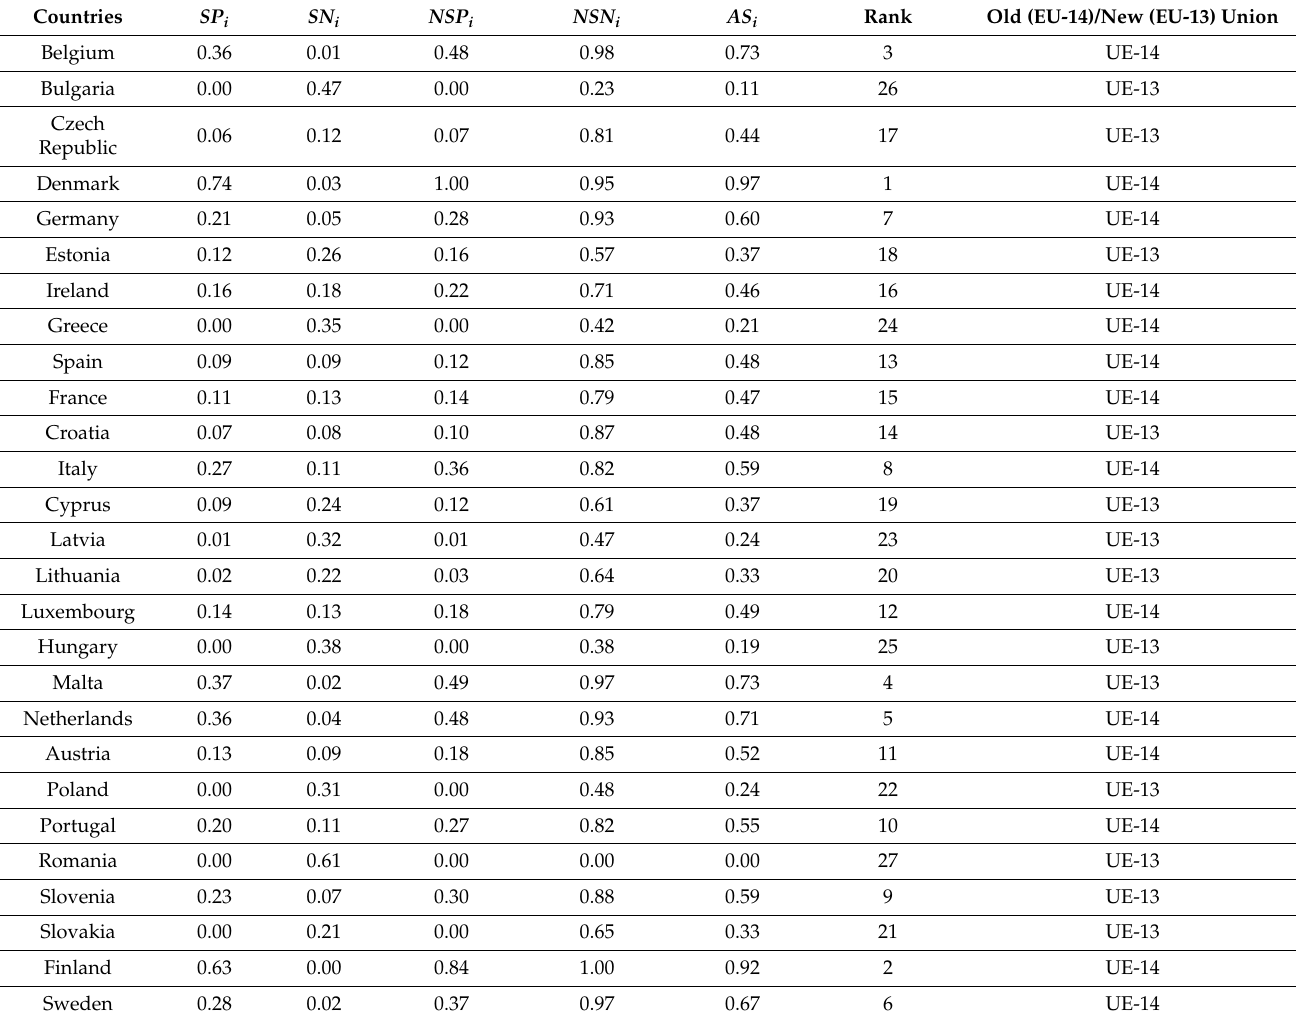
Table 7. The results of calculating the basic parameters by the entropy-EDAS method and the value of appraisal score along with a given country’s ranking in terms of SEM digital